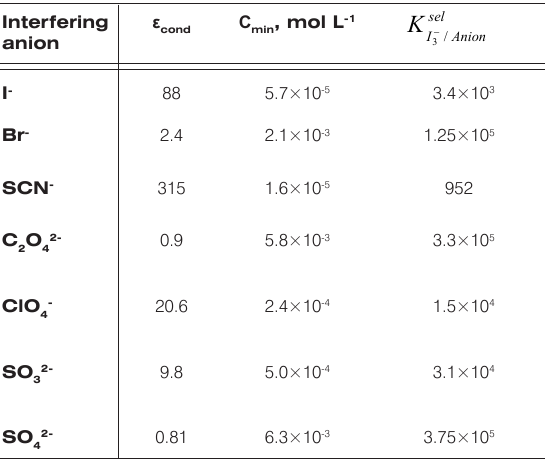
Table 2. Analysis of real samples ( ω – mass fraction, s